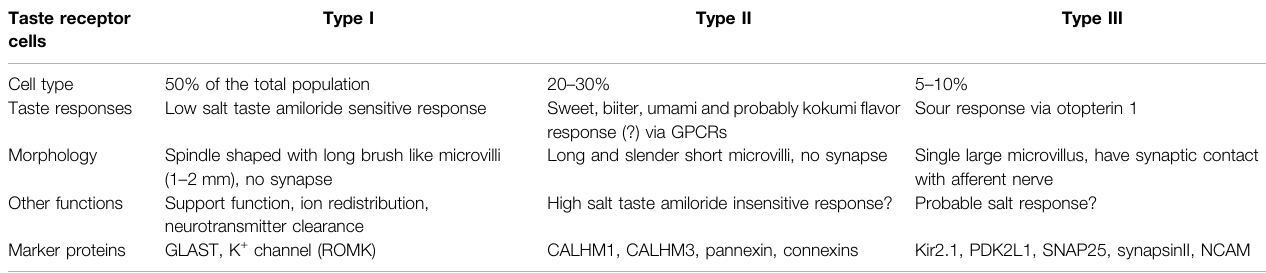
TABLE 2 | Summary of taste receptor cell characteristics. Taste receptor